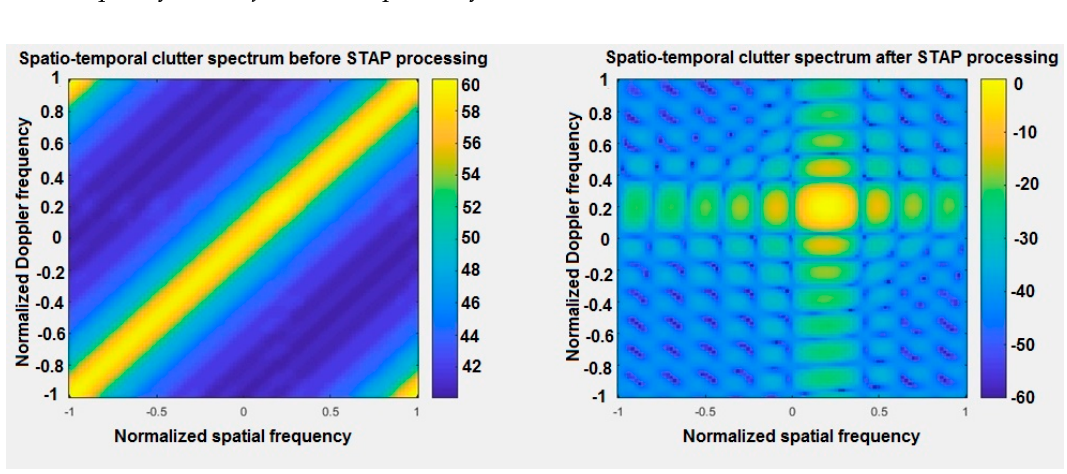
Figure 2. Space-time spectrum of clutter before and after STAP processing—2D charts.